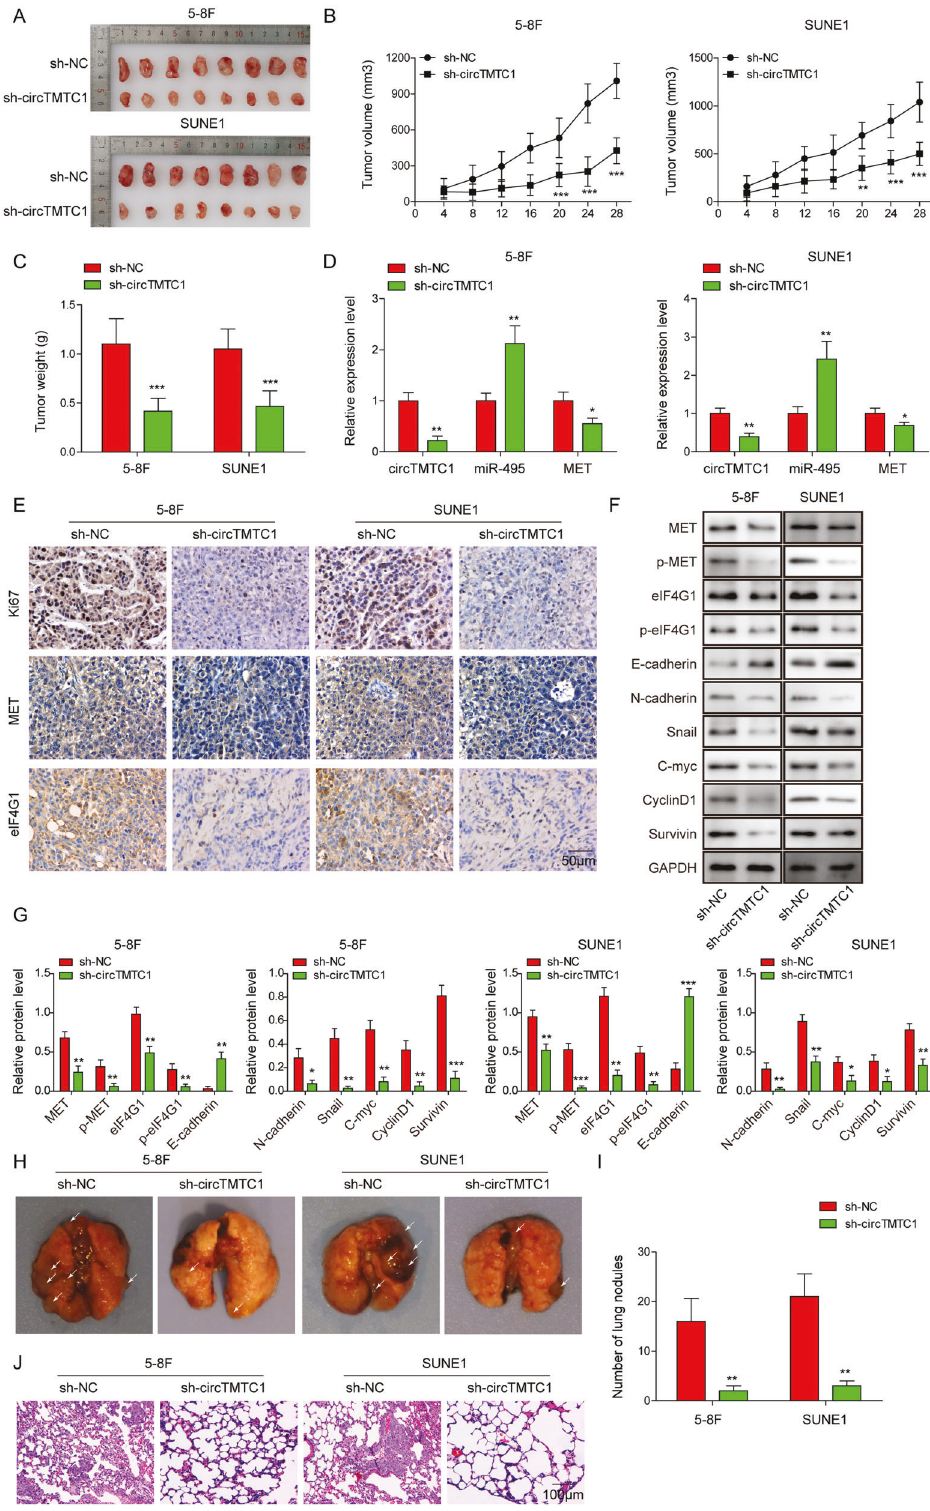
Fig. 8 CircTMTC1 silence suppressed NPC growth and lung metastasis through targeting the miR-495-MET-eIF4G1 axis in vivo. A Photos of excised tumors from subcutaneous xenograft mice. B Tumor volume was monitored every 4 days. C Weight of excised tumors. D The abundance of circTMTC1, miR-495, and MET mRNA by qRT-PCR in tumor tissues from subcutaneous xenograft mice. E IHC staining of Ki-67, MET, and eIF4G1 in tumor sections from subcutaneous xenograft mice. The result was representative of three independent experiments. F, G Western blotting analysis of MET, phosphorylated MET, eIF4G1, phosphorylated eIF4G1, E/N-cadherin, Snail, c-Myc, Cyclin D1, and Survivin. H Photos of excised lungs from intravenous xenograft mice. I Number of tumor nodules in the lungs. J H&E staining of lung sections from intravenous xenograft mice. * P < 0.05, ** P < 0.01, and *** P < 0.001.